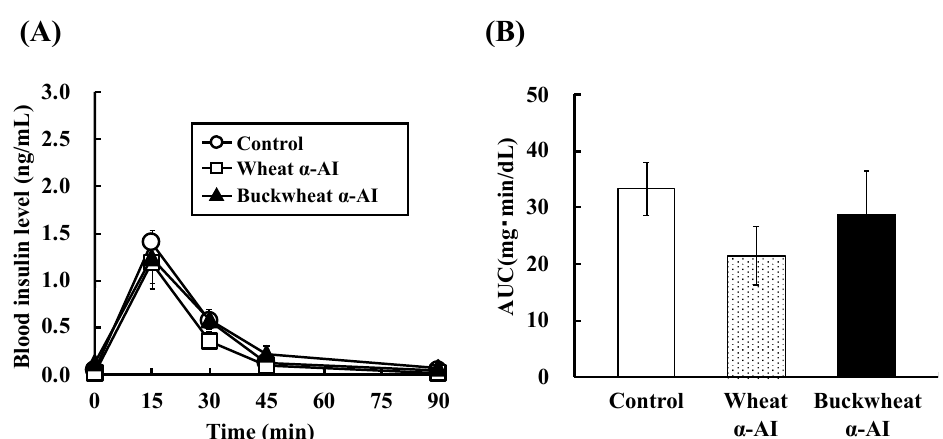
Figure 5. Effect of wheat and buckwheat α -AIs on ( A ) plasma insulin level and ( B ) insulin AUC after oral glucose tolerance test using Wistar rats. Each value is the mean of seven experiments with S.E. shown as a vertical bar. Values with different letters are significantly different at p < 0.05.